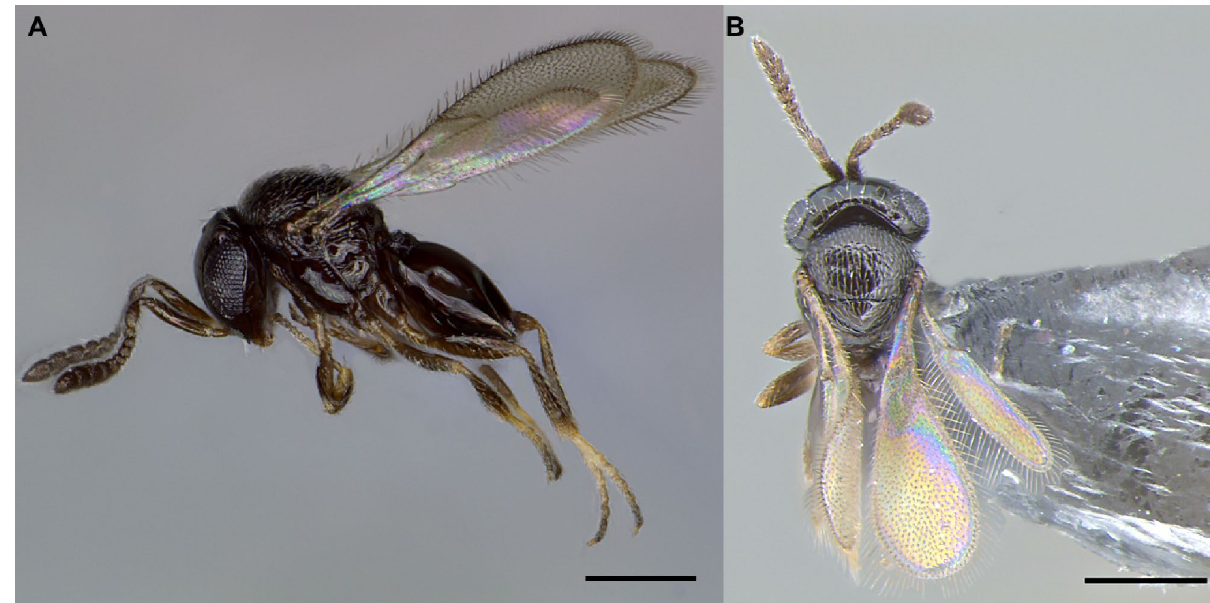
Figure 1. Telenomus remus female (scale bare: 0.20 mm): ( A ) Side view. ( B ) Dorsal view.